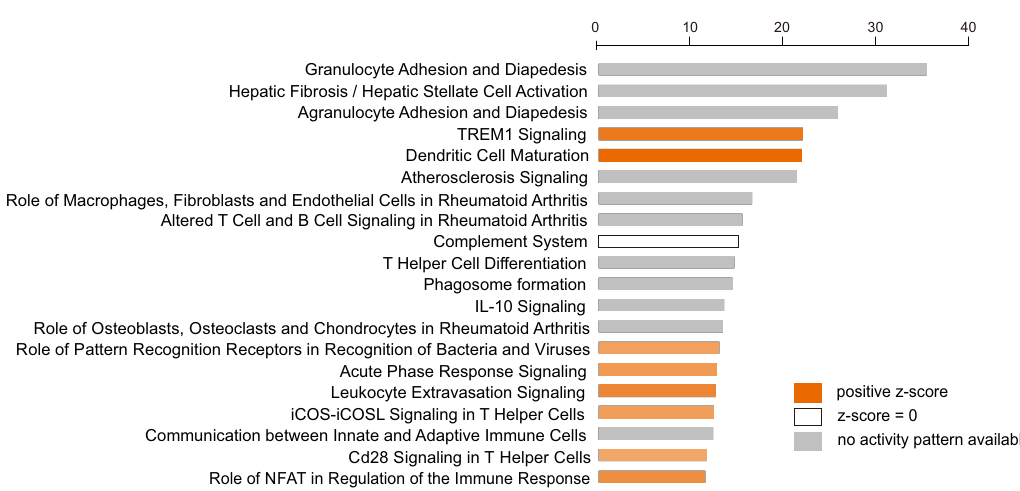
Figure 4. Pathway analysis based on 904 genes di ff erentially expressed between the silence of Hippo (SOH) and active Hippo subgroups in The Cancer Genome Atlas. The top 20 canonical pathways are shown. Only pathways with significant positive z-score are marked with color. Various immune-associated pathways are significantly enriched in the SOH